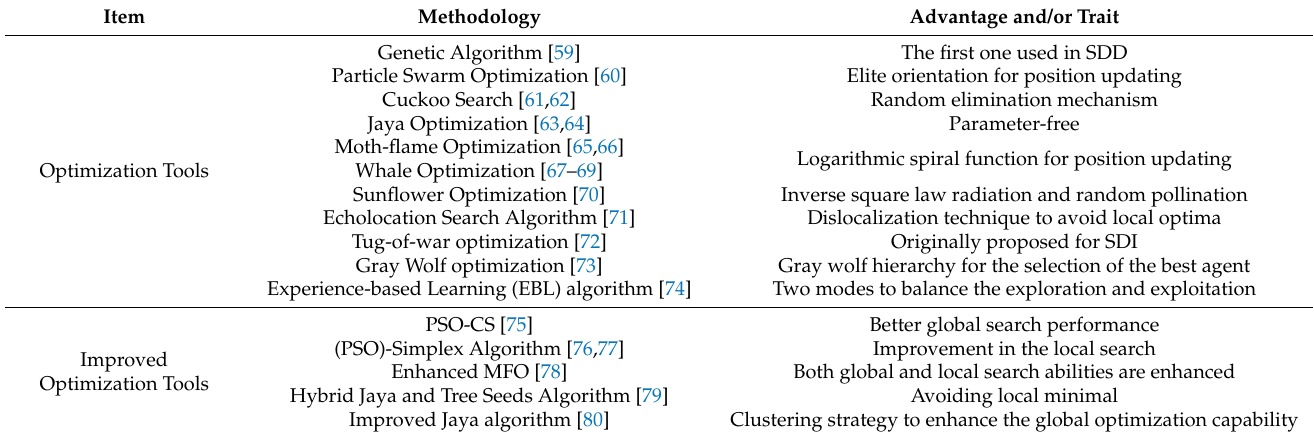
Table 1. The optimization tools adopted in FEM-updating SDD